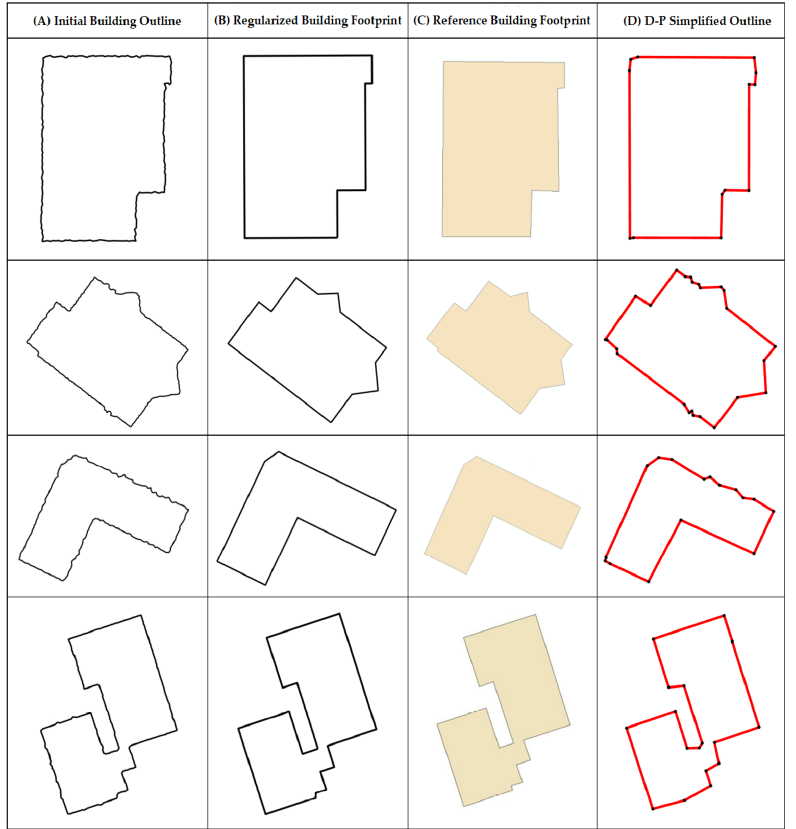
Figure 17. Comparison of Initial Building Outline, Regularized Building Footprint, Reference Build- ing Footprint and D-P Simplified Outline. The first three examples are in the Santa Rosa dataset. The last example is in Toronto dataset.